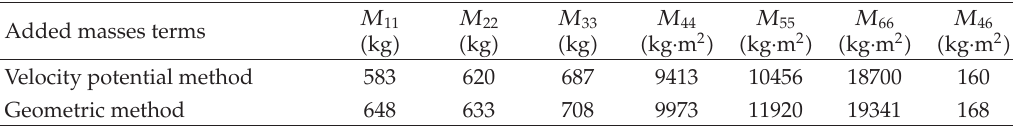
Table 2: Comparison between the two methods of